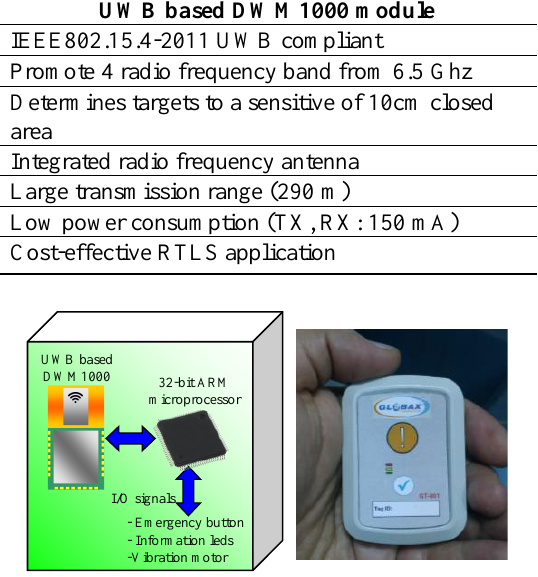
Figure 4. Tag topology structure and photograph in used RTLS.